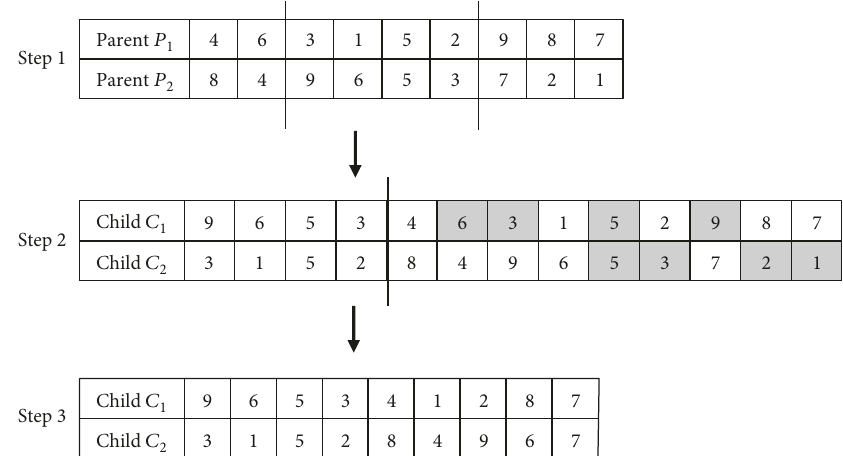
Figure 2: An example of crossover